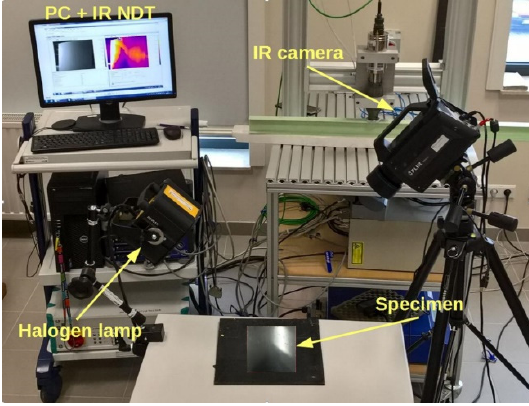
Figure 4. Non-contact active-IRT analysis for debond detection in the ACCS.